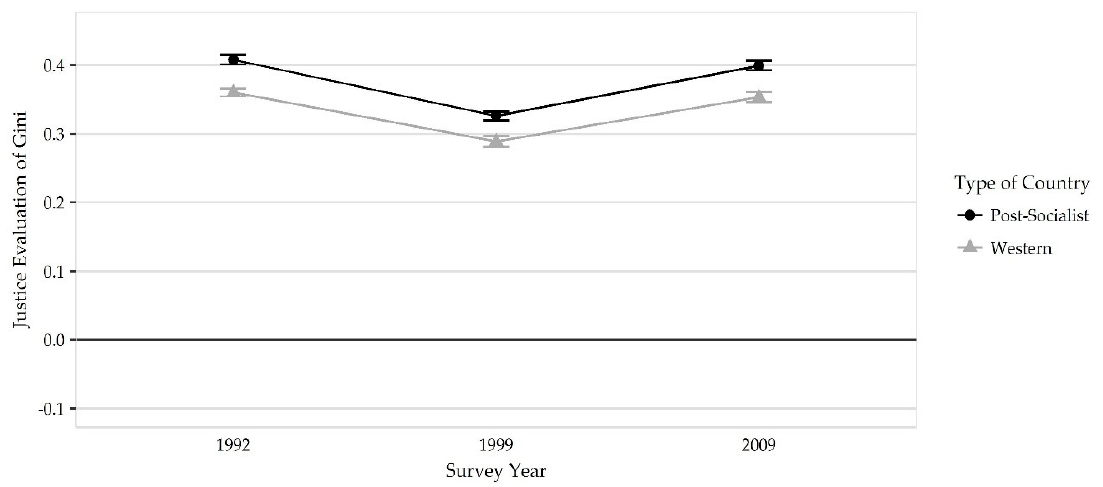
Figure 1. Overview of Differences in Justice Evaluations of Income Inequality between Post-socialist and Western Countries. Notes: ISSP, own calculations. Means with 95% confidence interval.